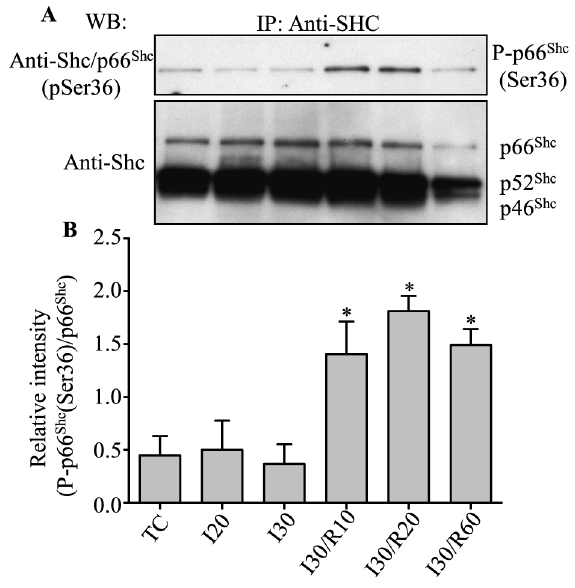
Figure 1. Phosphorylation of p66 Shc at Ser36 increased during reperfusion (R) after ischemia (I) in isolated guinea pig hearts compared to no ischemia (time controls, TC). A , upper panel: phosphorylation of p66 Shc at Ser36 from total protein lysate of heart tissue. A , lower panel: total p66 Shc level for loading control. Summary of mean band intensities ( B ) derived from three independent experiments (n 5 3 hearts/group); band intensities were determined by densitometry using imageJ software and the intensities of P-p66 (Ser36) were normalized to the total p66 Shc in each sample. P , 0.05: *IR vs. TC and I.